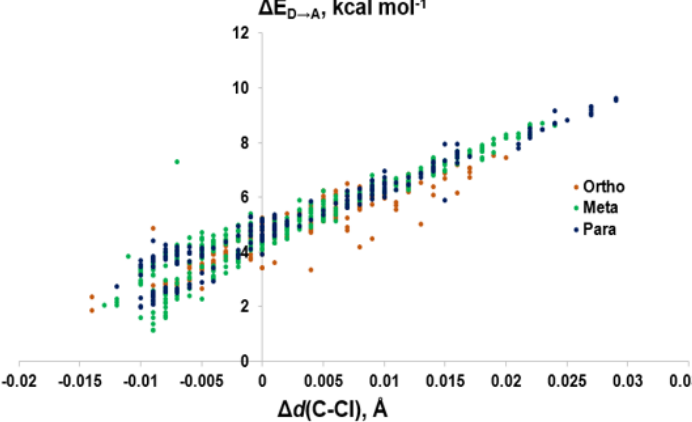
Figure 10. Comparison of donor-acceptor energies ( Δ E D → A ) to the activation of the C ‒ Cl bond ( Δ d (C ‒ Cl)) by XB position.